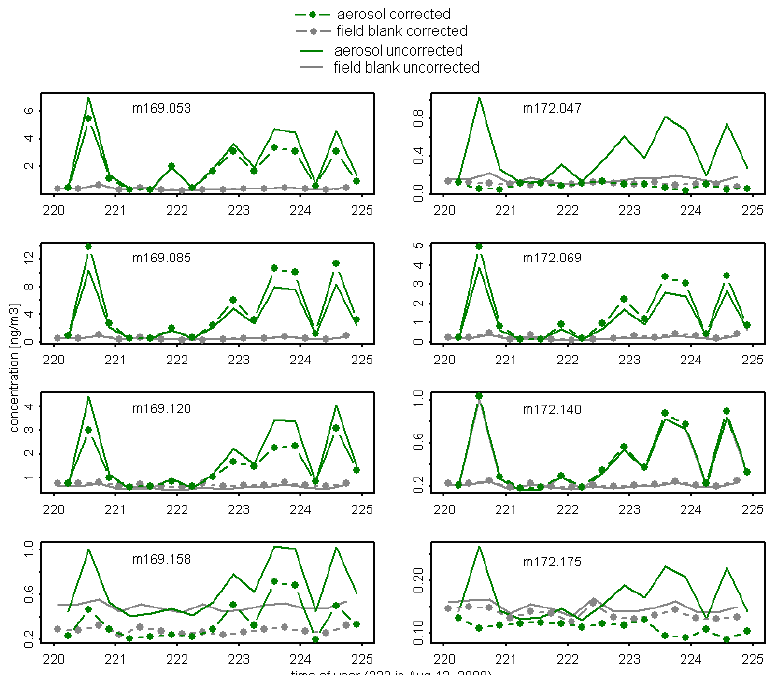
Figure D3. Five day time series of ions detected at nominal masses 169 and 172 (Aerosol inlet B). Data printed in grey represent field blank measurements; data printed in green are aerosol sample data. Solid lines are uncorrected data and the series with symbols have been corrected for the signal from overlapping neighbouring peaks. After correction, all four peaks detected at mass 169 are still enhanced in aerosols. At mass 172 only two compounds are present in aerosols (masses 172.069 and 172.140 Da). The signals detected at masses 172.047 and 172.175 were entirely attributed to their overlapping neighbours. After the correction their signals were no longer above the field blank measurements.